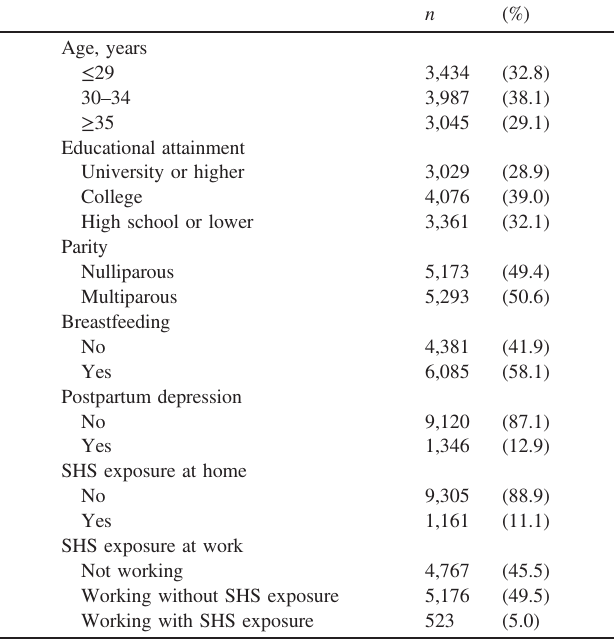
Table 1. Characteristics of participants: the Tohoku Medical Megabank Project Birth and Three-Generation Cohort Study ( n = 10,466)